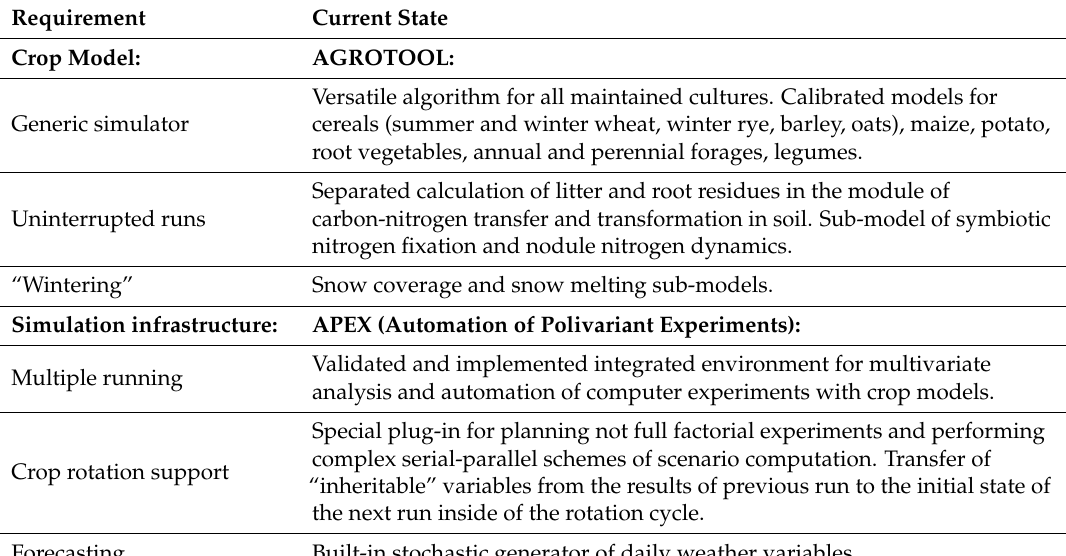
Table 3. APEX and AGROTOOL for crop rotation